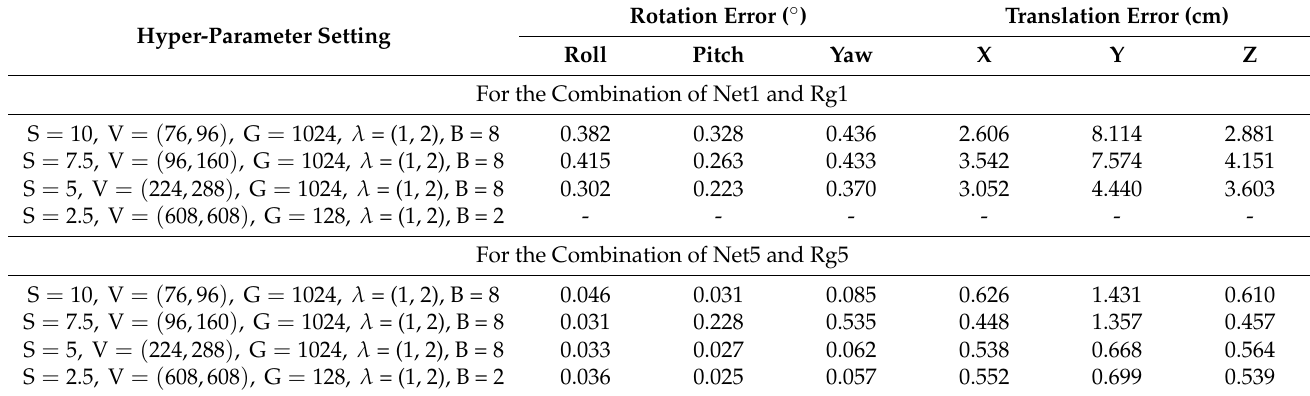
Table 7. Comparison of calibration performance according to S on the Oxford